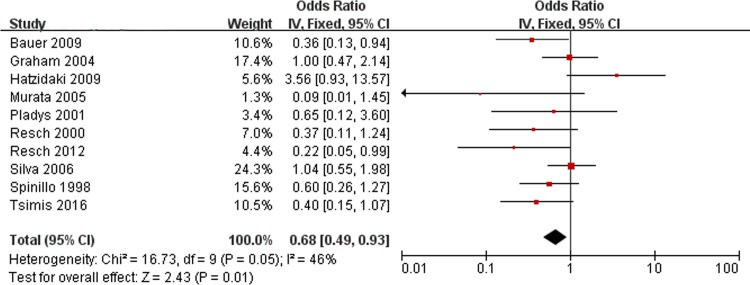
Fixed-effect model forest plot of the odds ratio of the association between preeclampsia/eclampsia and PVL.The pooled OR of preeclampsia/eclampsia is presented as a solid diamond at the bottom of the forest plot, the width of which represents the 95% CI.